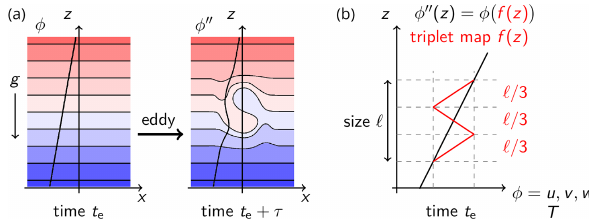
Figure 2. (a) Schematic of an eddy turnover illustrated for an ini- tially linear property profile φ ( z ), where φ stands representative for u , v , w , and T . The initial flow state at time t = t e is denoted as φ ( z ), and the final state at t = t e + τ by φ (cid:48)(cid:48) ( z ), where τ is the eddy turnover time. (b) Visualization of the triplet map f ( z ) that models the microstructure of turbulent “eddies” and is used to formulate the discrete ODT “eddy” events. Eddy events are defined by the random variables location z e , size (cid:96) , and occurrence time t e . Stochastically sampled eddy events punctuate the deterministic flow evolution at times t e and are sampled with a local rate that depends on the mo- mentary flow